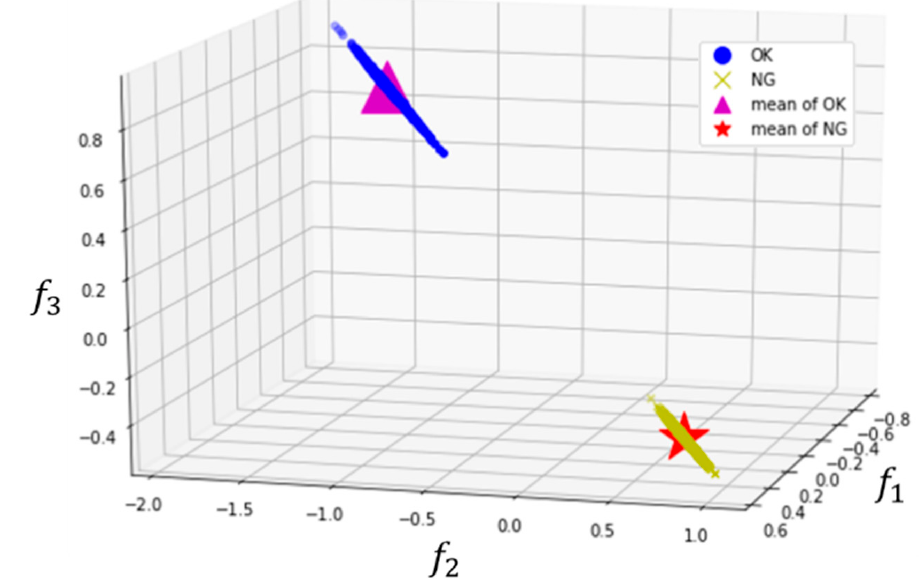
Figure 4. The clustering feature diagram.